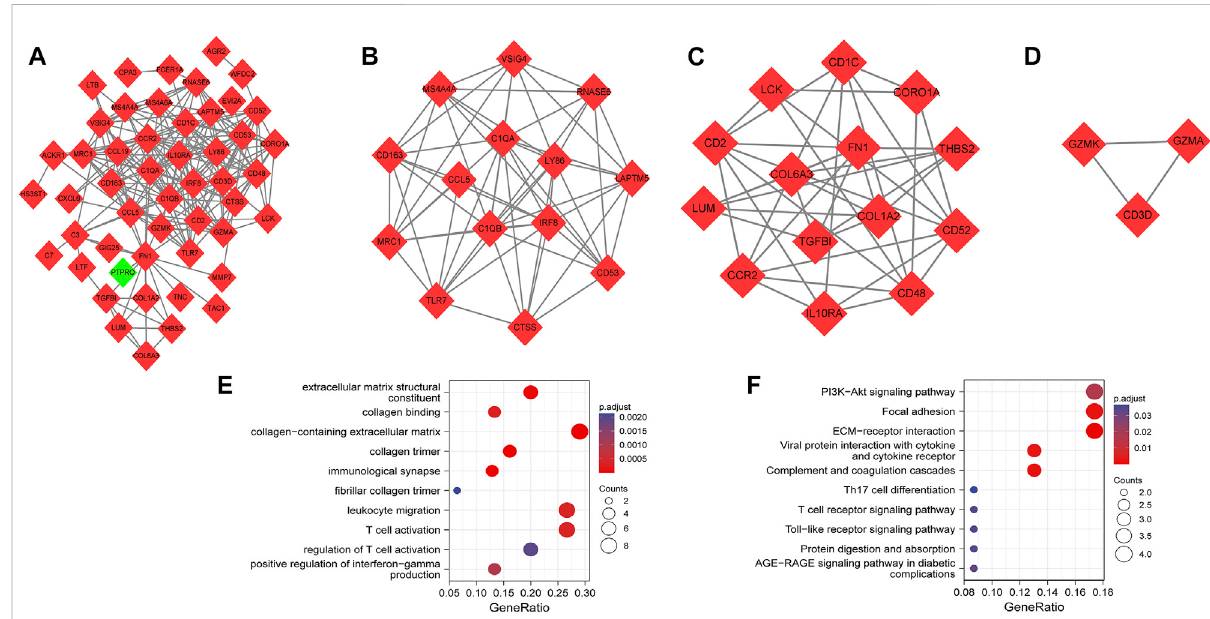
FIGURE 3 PPI network, highly connected subnetworks, and enrichment analyses of genes involved in subnetworks. (A) The PPI network included 50 nodes and 217edges.Reddiamondsrepresentupregulatedgenes,whilegreendiamondrepresentsdownregulatedgenes. (B – D) Threehighlyconnectedsubnetworks have the gene-level score of 9.077, 6, and 3, respectively. Red diamonds represent upregulated genes. (E) GO analysis of the total genes involved in subnetworks. (F) KEGG pathways of total genes involved in subnetworks. Size of the circles represents the number of enriched